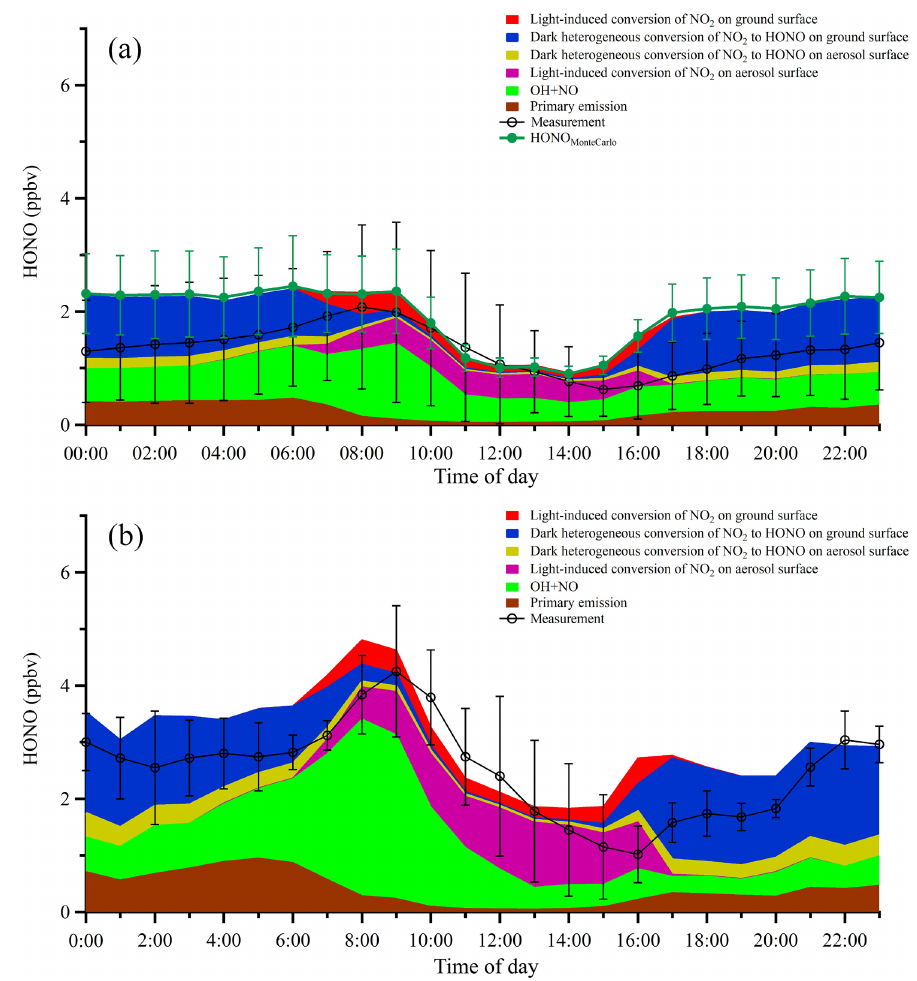
Figure 10. (a) Averaged diurnal profiles of the measured HONO and the modeled HONO from different sources. Error bars on the black line represent the standard deviations of HONO measurements in hourly bins. Error bars on the green markers denote the Monte Carlo analysis results. (b) The same plot as panel (a) except that only the two industrial plume events (7 December and 21–22 December 2015) were considered in the